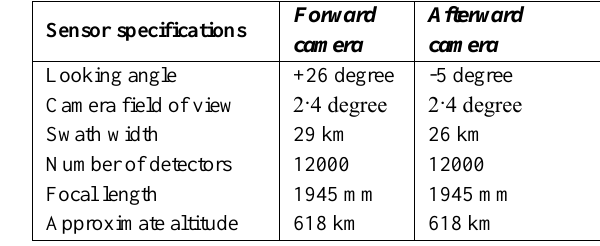
Table 1: Geometric Specifications of the Cartosat-1 Stereo Images